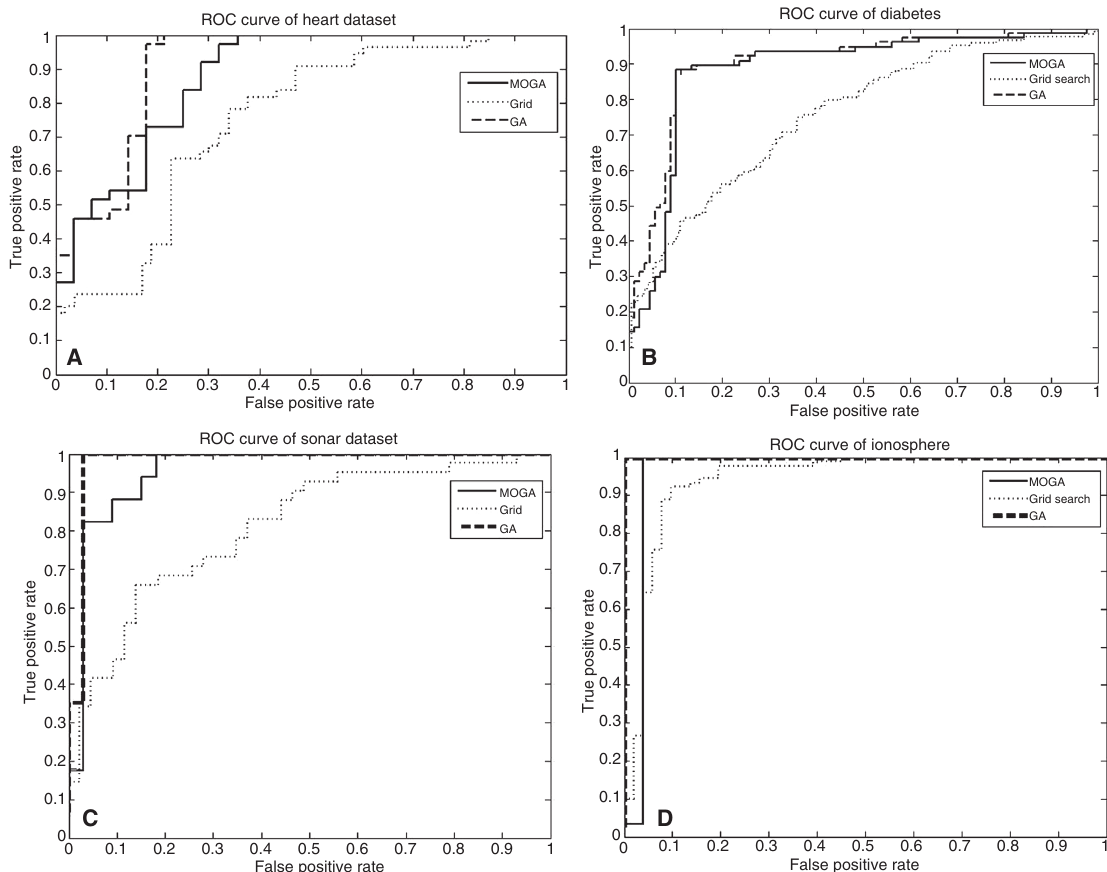
Figure 4. ROC Curves for the (A) Heart Disease, (B) Diabetes, (C) Sonar, and (D) Ionosphere Data Sets.